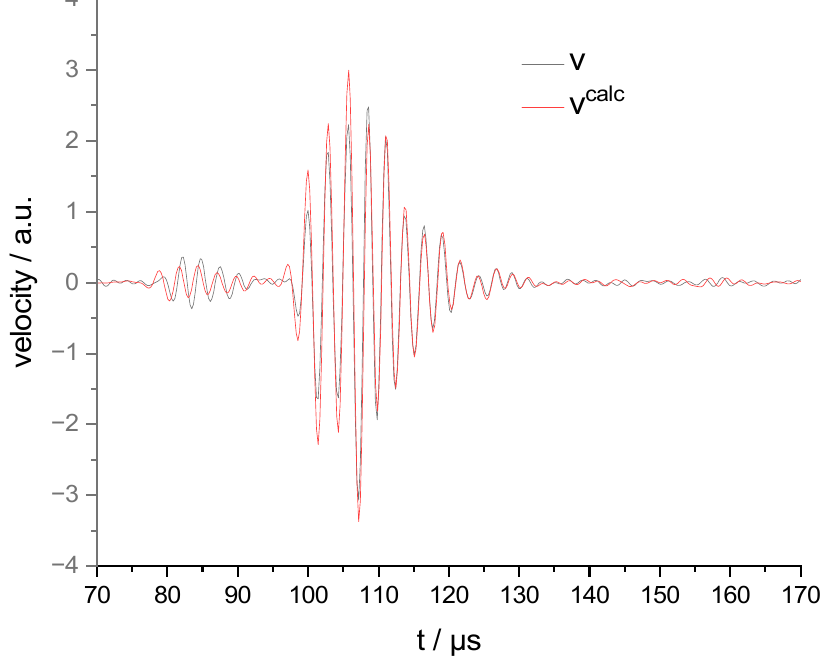
Figure 5. Comparison of the measured surface normal velocity v with transducer as sender and the given (non δ -pulse like) current excitation with v calc calculated according to (16) from the data of the transducer as receiver. Both quantities are shown at arbitrary scales.